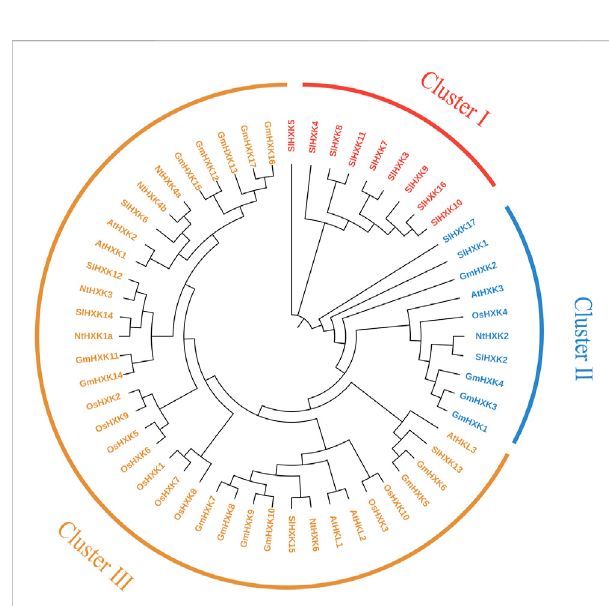
FIGURE 2 Phylogenetic analysis of the HXK gene family from G. max and otherplantspecies.At, A.thaliana ;Gm, G.max ;Sl, S.lycopersicum ;Os, O. sativa ; Nt, N. tobacum. The amino acid sequences of HXK were aligned by Clustal X, and the tree was generated using the neighbor-joining method in MEGA-X with 1,000 bootstrap